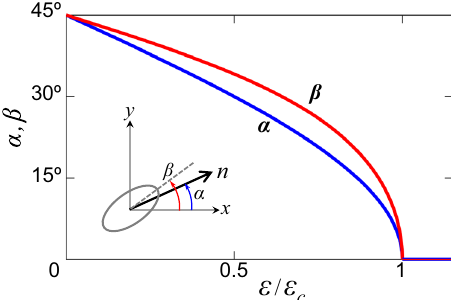
Fig. 4 | Rotation of the staggered moment and orthorhombic axis under uni- axial strain. Angles α and β which specify the staggered moment direction and lattice deformation axis (see inset), correspondingly, as a function of strain ε applied along the [1 1 0]